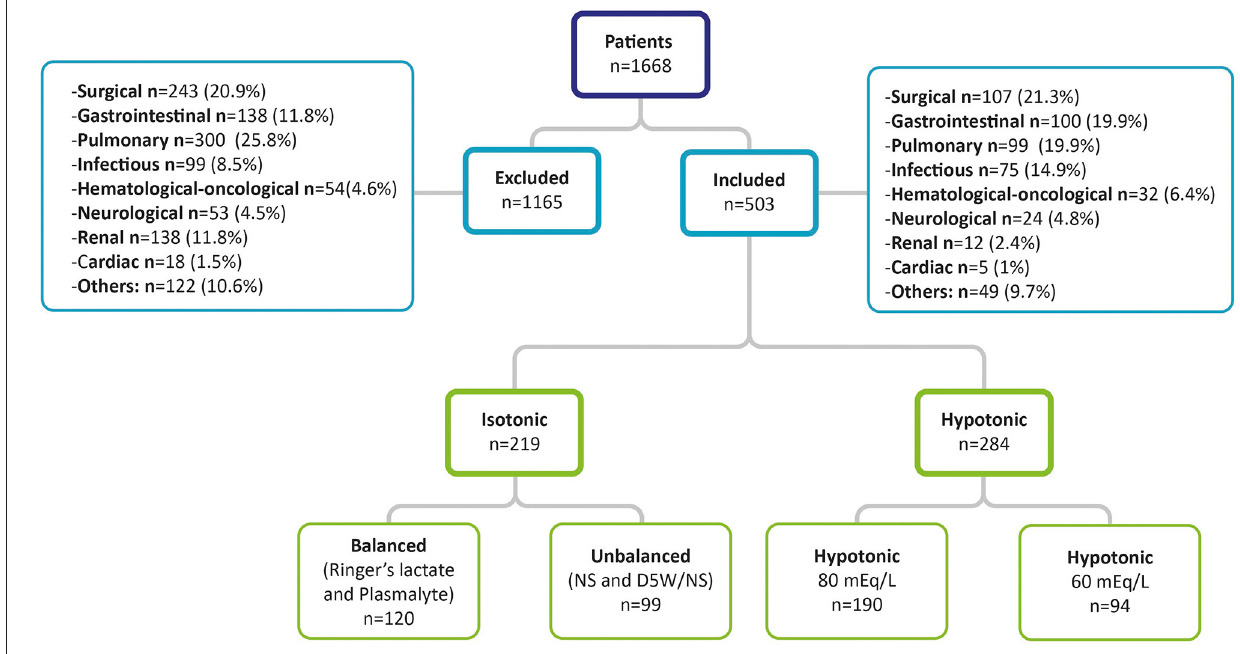
FIGURE 1 | Study population.